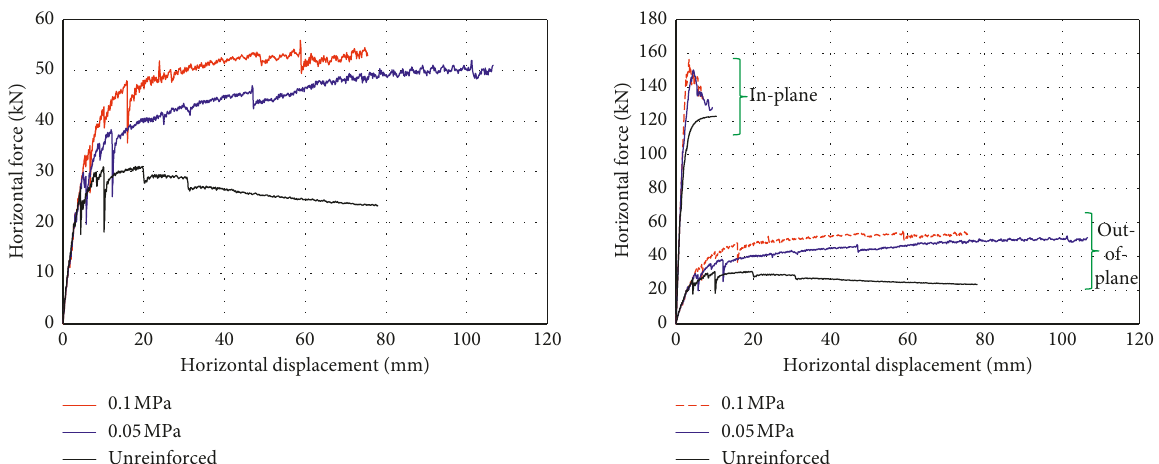
Figure 7: (a) Results obtained for the case of out-of-plane horizontal loading. (b) Comparison between the in-plane and out-of-plane horizontal loading cases.